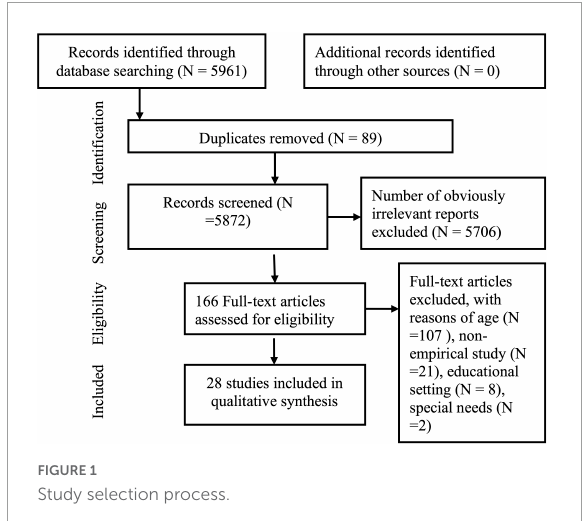
FIGURE1 Study selection